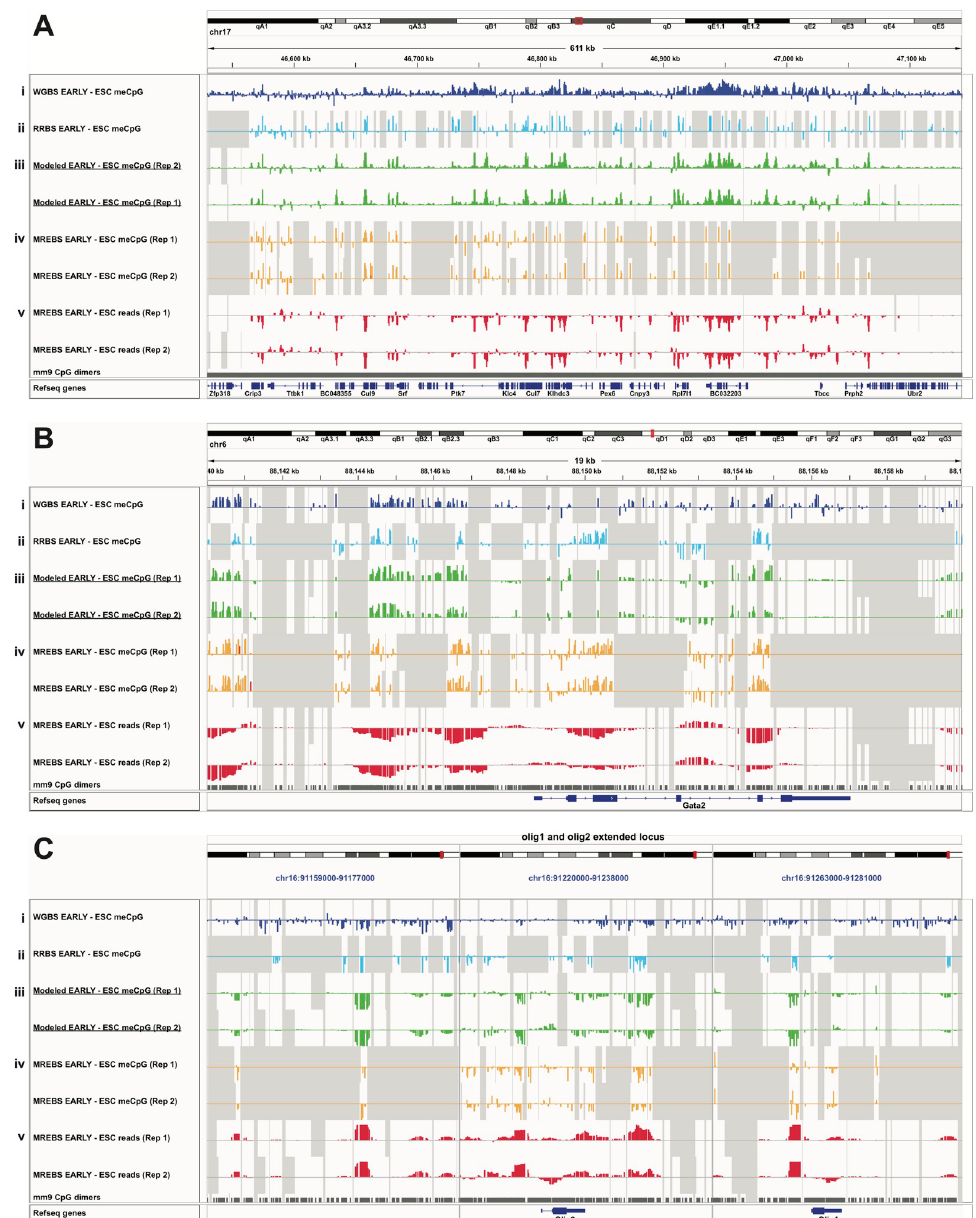
Fig 4. Differential DNA methylation levels modeled using MREBS data. A. IGV tracks of differential DNA methylation estimates between EARLY intermediates and ESCs (EARLY—ESC) based on WGBS data (i, dark blue), RRBS data (ii, light blue), modeled data based on combined model 2 (iii, green, two replicates), MREBS conversion-based DNA methylation estimates (iv, orange, two replicates), and MREBS read count-based estimates (v, red, two replicates), within a 611 kb region of chr17. Bottom two tracks show CpG dimer and Refseq gene locations. Gray background reflects regions (CpG dimers) where data was not available. B. As in (A), but for a 19kb region around the Gata2 gene. C. As in (A), but for the extend Olig1/2 gene locus, divided into three 18 kb